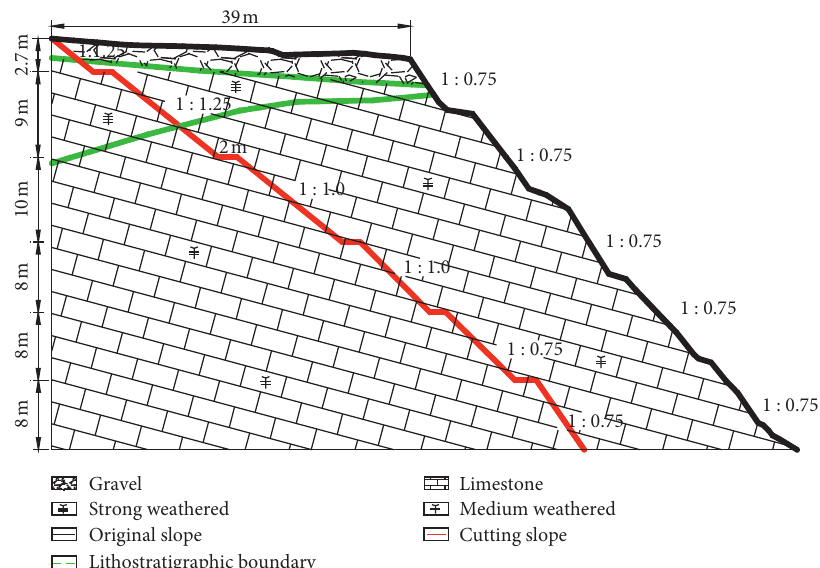
Figure 4: Geologic profile in K503 +585 ∼ 504+ 018